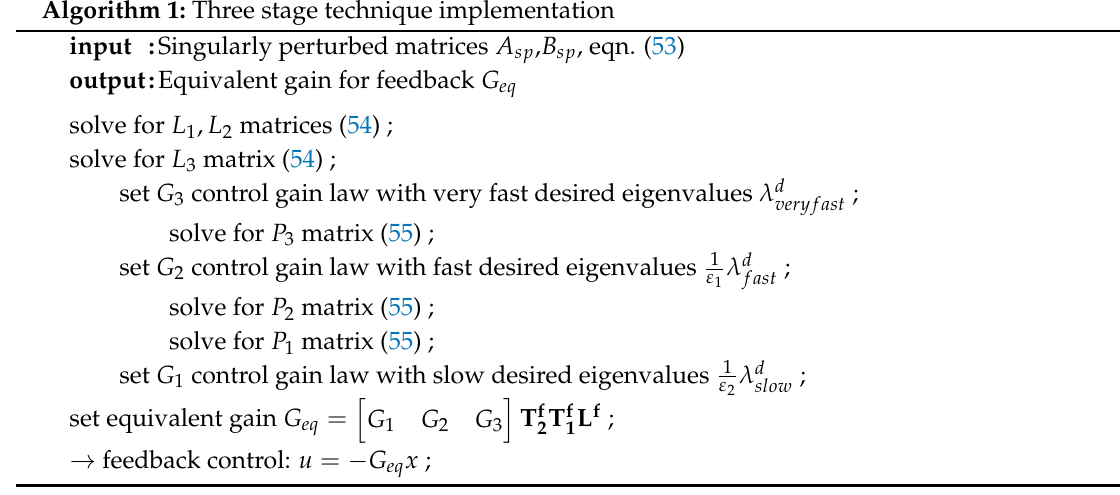
Algorithm 1: Three stage technique